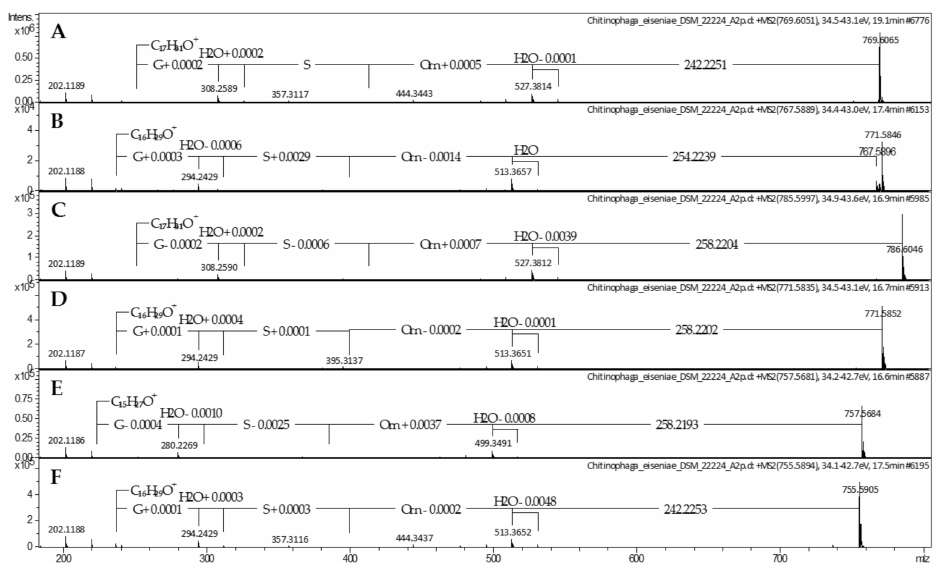
Figure 3. MS/MS spectra of lipoamino acids 5 ( A ), 6 ( B ), and 8 – 11 ( C – F ) produced by Chitinophaga eiseniae DSM 22224.